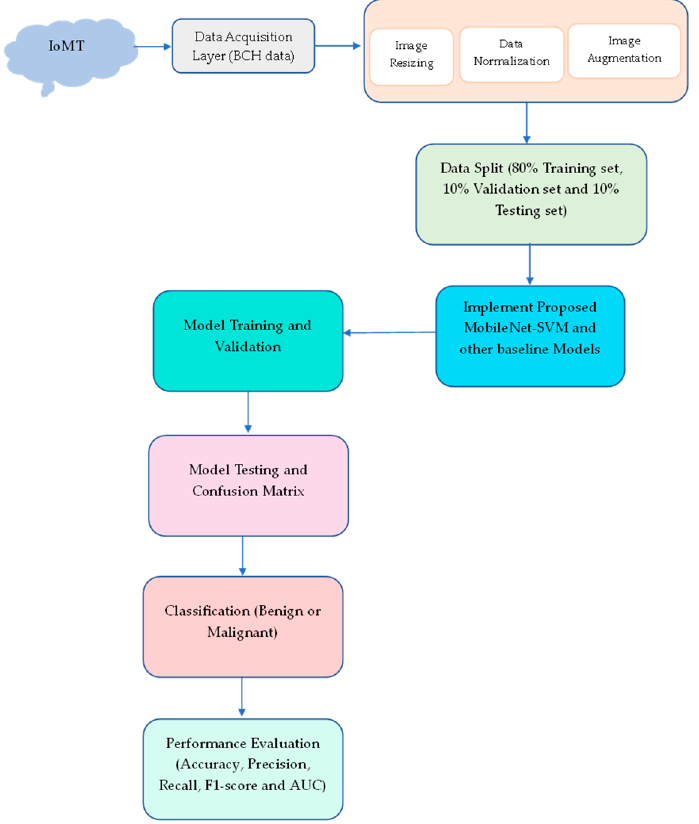
Figure 2. Proposed model flow